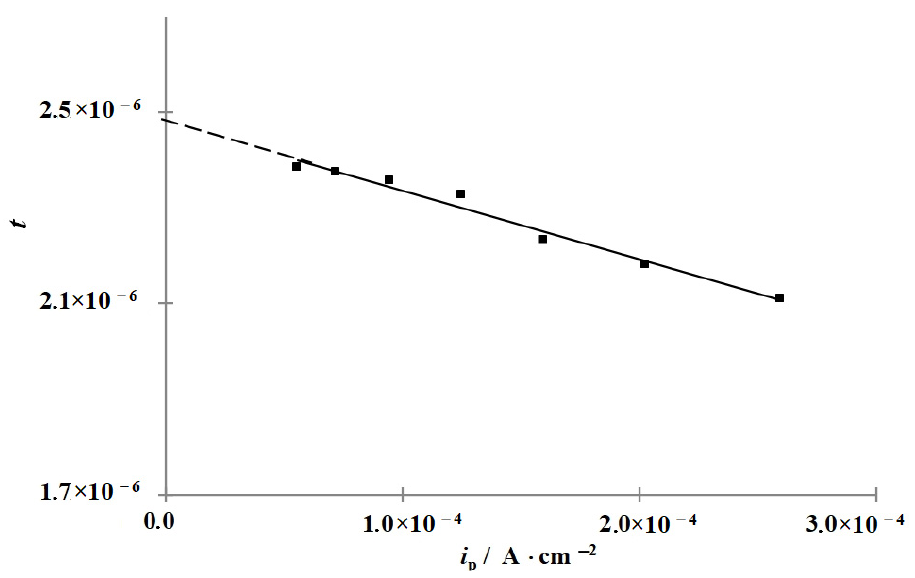
(cid:16) (cid:17) ) vs. the current of hydrogen penetration through the ) vs. the current of hydrogen penetration through the α FE vs. the current of hydrogen penetration through the (cid:3019)(cid:3021) (cid:3019)(cid:3021) RT